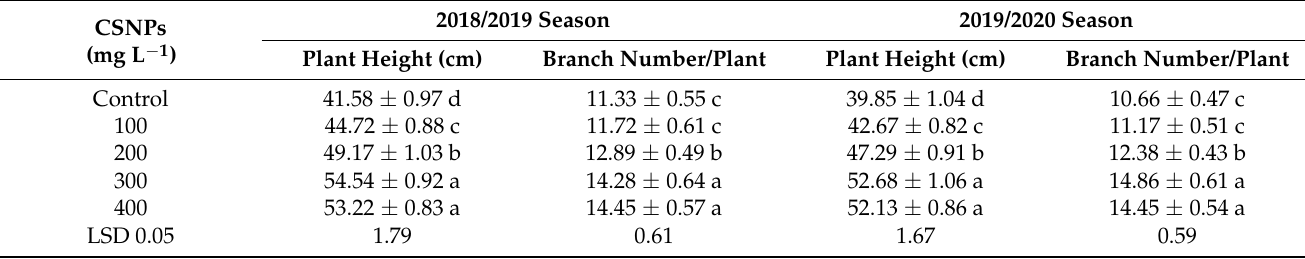
Table 1. Impact of chitosan nanoparticles (CSNPs) on plant height and branch number of Matricaria chamomilla L. in the two experimental seasons. Data are means ± SE ( n = 3). In each column, least significant difference was calculated and letters represent statistical differences among treatments at p ≤